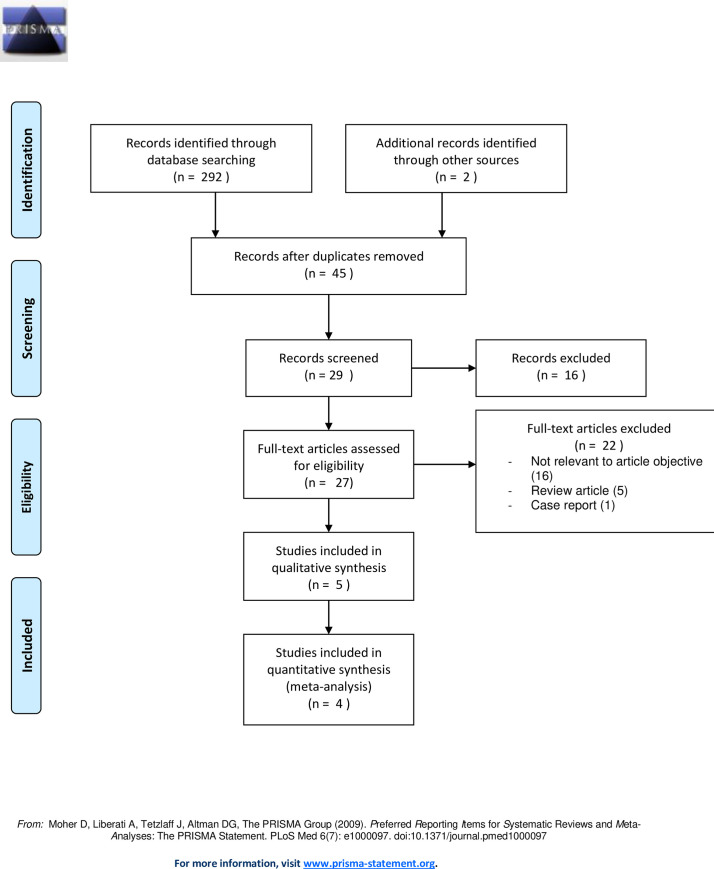
PRISMA 2009 flow diagram.